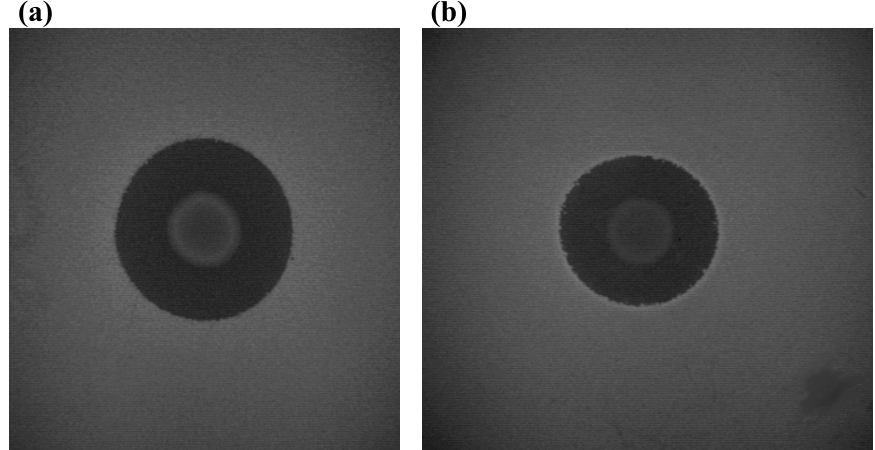
Figure 3. Inhibition of staphylococcal strains by lysostaphin tested by the deferred- antagonism test in BHI medium. (a) S. aureus QRFH1, isolated from cheese (inhibition zone of 22 mm). (b) S. xylosus CN93, isolated from human skin (inhibition zone of 19.5